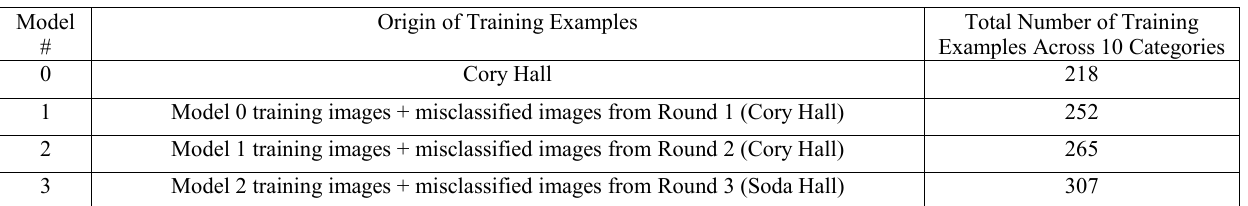
Table 2: Detailed description of the training set used for each